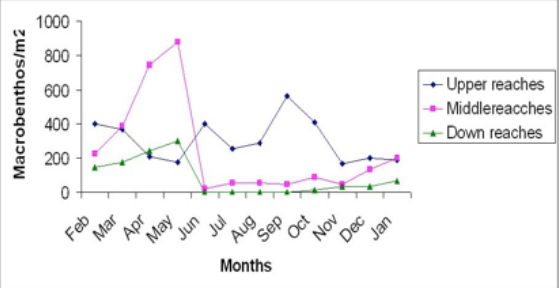
Figure 1. Variations of macrobenthic density in Ichamati